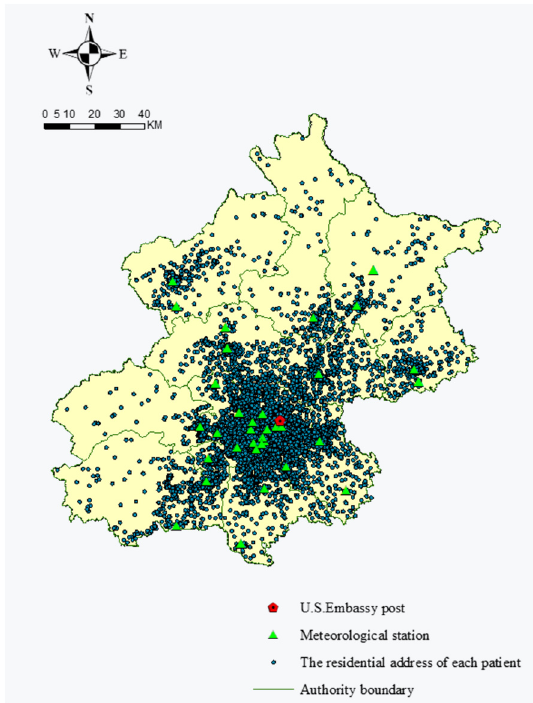
Figure 1. Spatial distribution of 35,989 patients’ residence and 34 air quality monitoring stations.